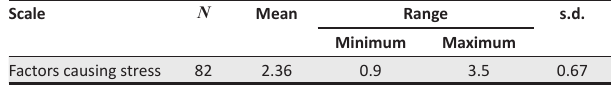
TABLE 5: Mean of factors causing